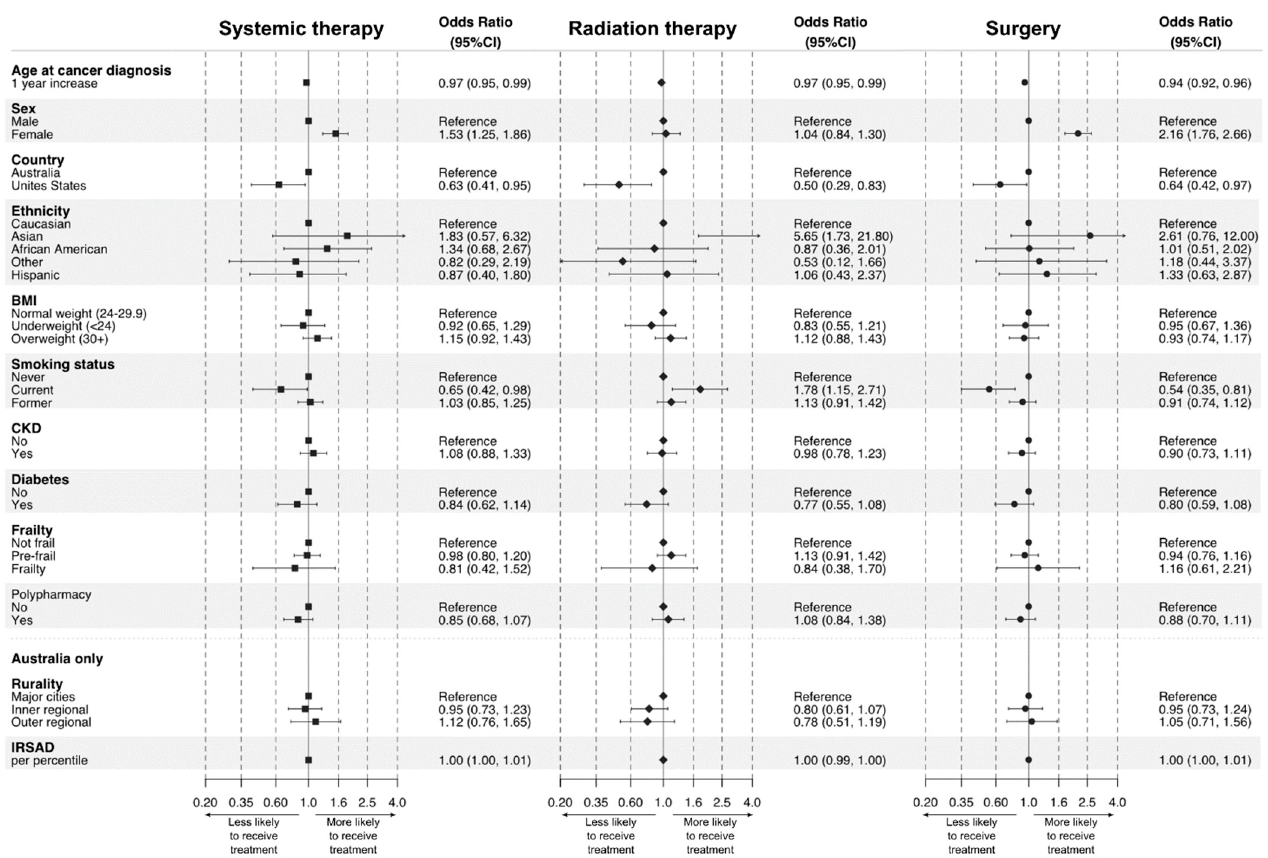
Figure 2. Associations between demographic factors, health behaviours, and chronic conditions and receipt of systemic therapy, radiation therapy, and surgery for incident post-randomisation cancers during ASPREE (Note that the models for each modality are independent of one another, and therefore ORs cannot be compared between modalities).